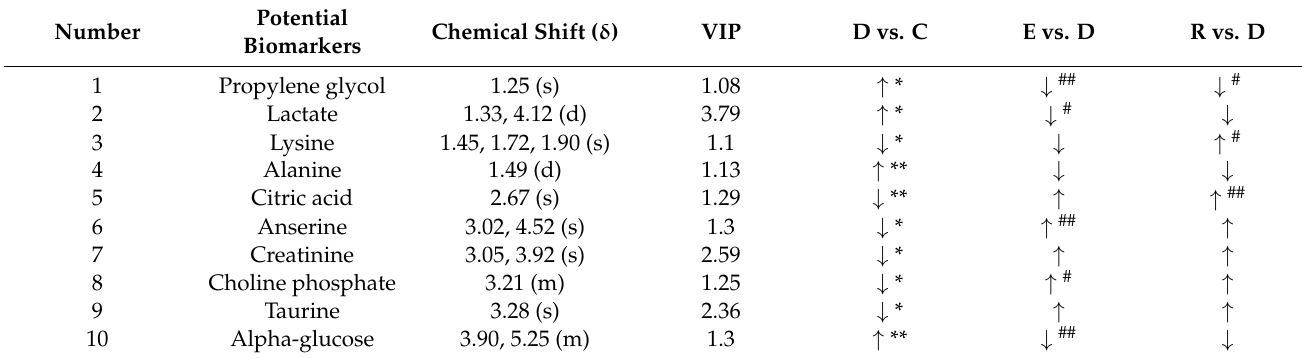
Table 1. Ten metabolites and their trends of change in the gastrocnemius muscle.